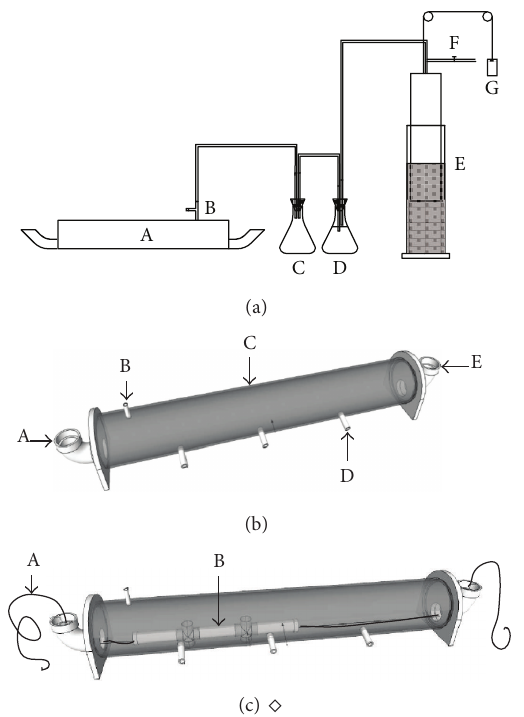
Figure 2: System diagram and digester designs: (a) system diagram showing the layout of the various components ((A) digester vessel; (B) gas sampling port; (C) foam trap; (D) bubbler; (E) displacement gas meter; (F) biogas exhaust; (G) gas meter counterweight)); (b) construction schematic of the laboratory-scale Indonesian model , 𝑅 , and 𝑅 ((A) influent port - digester used for 𝑅 control- 1 control- 2 recycle 3.8 cm I.D. PVC elbow; (B) biogas outlet line; (C) digester body - 10.0 cm I.D. PVC pipe; (D) sampling port; (E) effluent port - 3.8 cm , which is the I.D. PVC elbow)); (c) construction schematic for 𝑅 mixer same as in (b), but a mixing rod has been added ((A) mixing wire and (B) internal mixing rod).